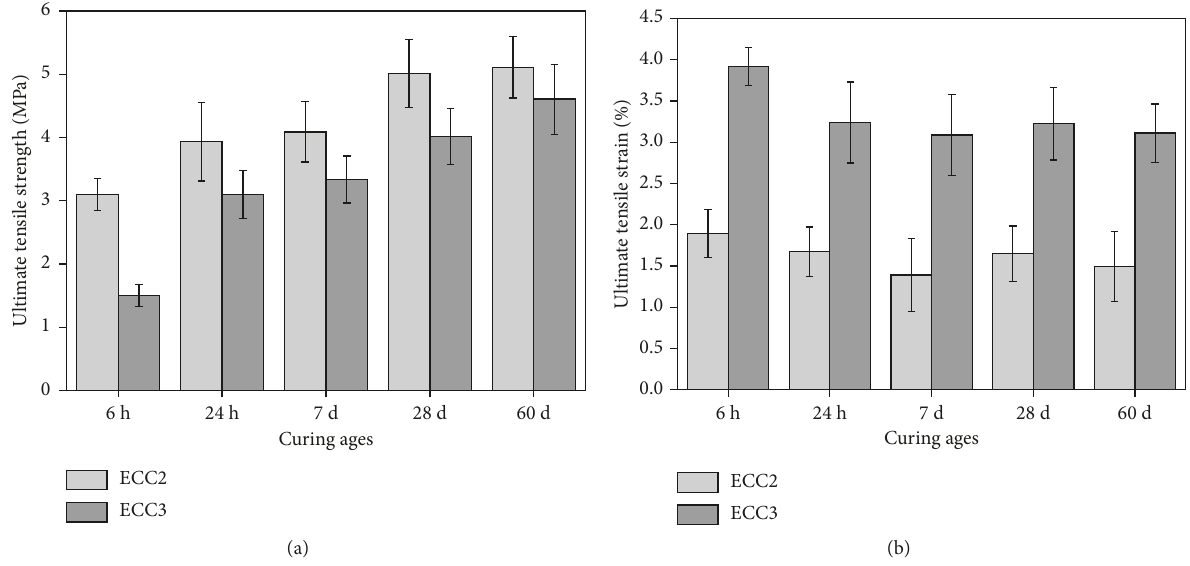
Figure 14: Comparison of tensile properties of HES-ECCs with different fibers at different ages: (a) ultimate tensile strength; (b) ultimate tensile strain. Table 5: Performance indices of strain-hardening for HES-ECCs when PE fiber content is 0.5% (ECC3). Curing ages